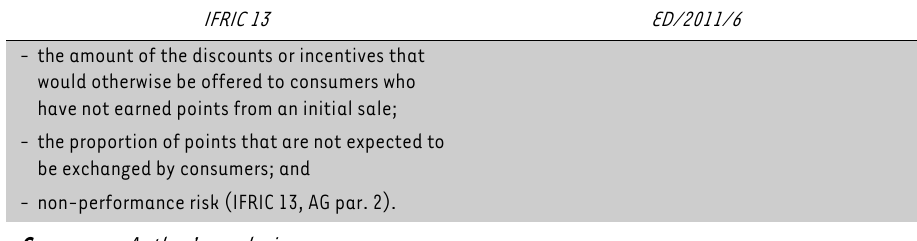
Table 2: The difference in the guidelines of IFRIC 13 and ED/2011/6 IFRIC 13 ED/2011/6 The portion of consideration allocated to the points granted in the underlying sales transaction shall be measured by reference to their fair value (IFRIC 13, par.